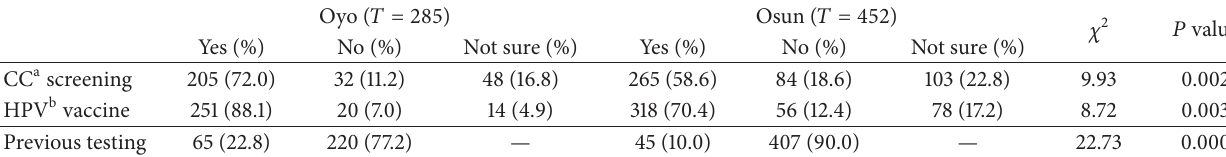
Table 3: Acceptability of Pap smear test and HPV